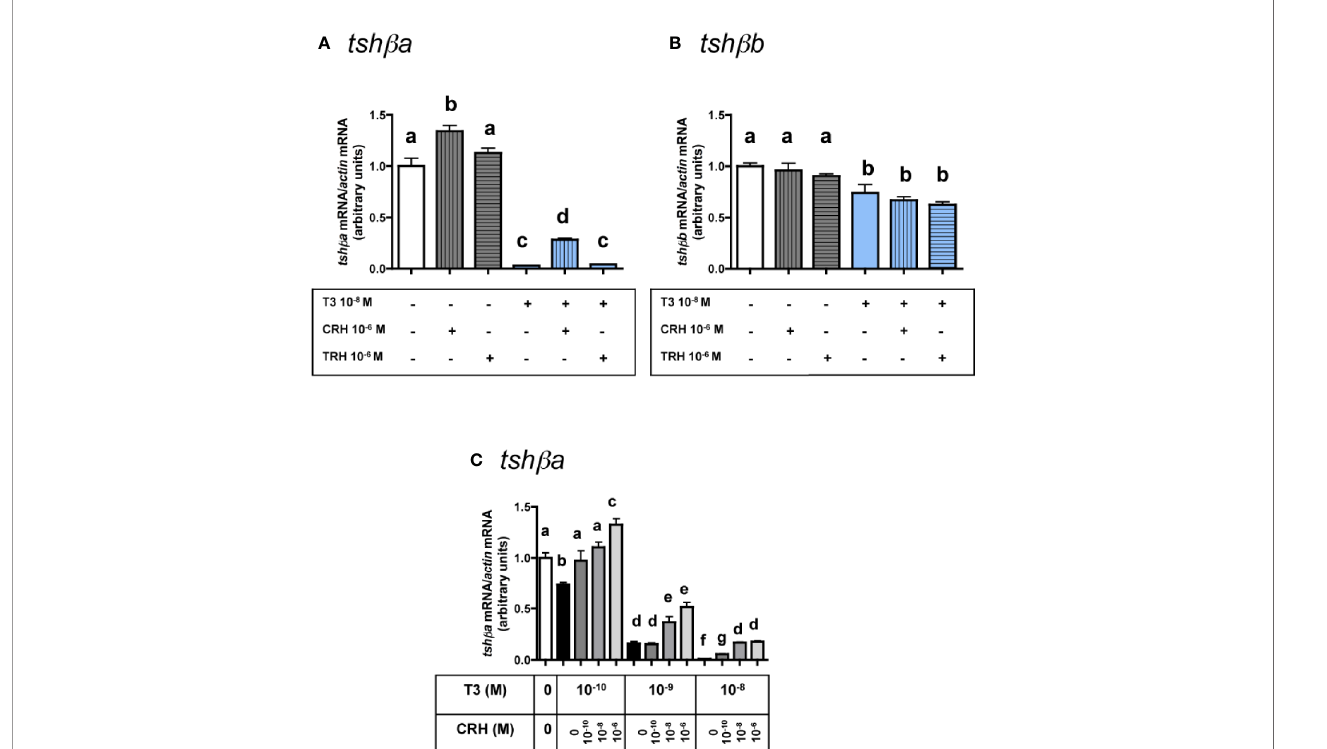
FIGURE 4 | Effects of CRH and TRH on tsh b a and tsh b b transcript levels in the presence of T3 in primary cultures of Atlantic salmon pituitary cells. Pituitary cells from juvenile Atlantic salmons were treated for 10 days with 10 -6 M of CRH or 10 -6 M TRH in the presence of 10 -8 M of T3, and mRNA levels of tsh b a (A) and tsh b b (B) were quanti fi ed by qPCR. In (C) , pituitary cells were treated for 10 days with various doses of CRH (10 -10 , 10 -8 , and 10 -6 M) in the presence of various doses of T3 (10 -10 , 10 -9 , and 10 -8 M) and mRNA levels of tsh b a were quanti fi ed by qPCR. The Figure displays the results from a representative experiment of three independent cell culture experiments. Mean ± SEM; n = 5 well replicates. Different letters indicate signi fi cant differences, ANOVA.